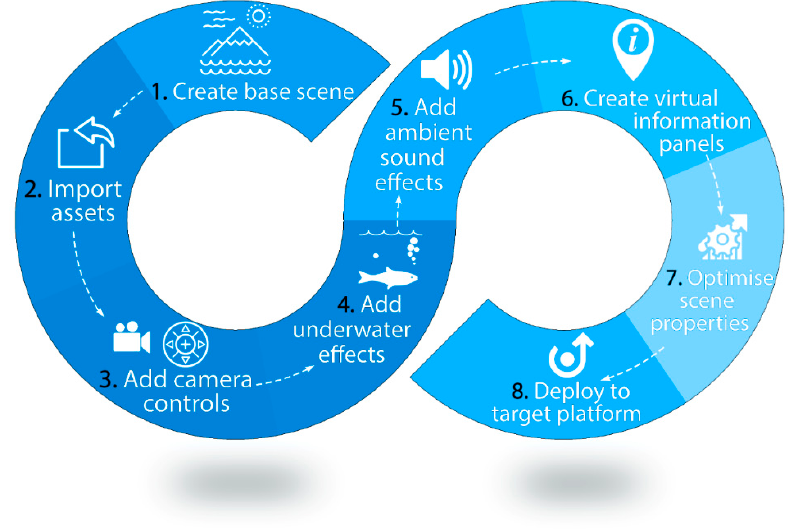
Figure 1. A schematic approach for creating virtual underwater scenes to advise diving campaigns.